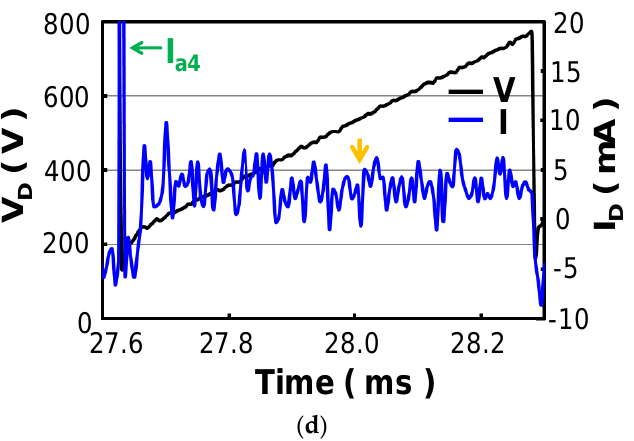
Figure 5. Drain voltage and current waveforms of the GaN HEMTs with the gate protection circuit, as shown in Figure 2. The GaN HEMTs was subjected to a 50 ms, 800 V pulse, and it was exposed to the air for ( a ) a whole stress period. ( b ) Zoomed − in picture of the region A in Figure 5a (at PD), which the slops at a3, a4 and a5 are different from that at a1 and a2 in A1 and A4; ( c ) zoomed – in picture of region B in Figure 5a (after the PD) , which still has PD’s as shown in b1 and b2 ; and ( d ) zoomed − in picture of the region a4, in Figure 5b, which the leakage current is nearly 5 mA as shown in yellow arrow.